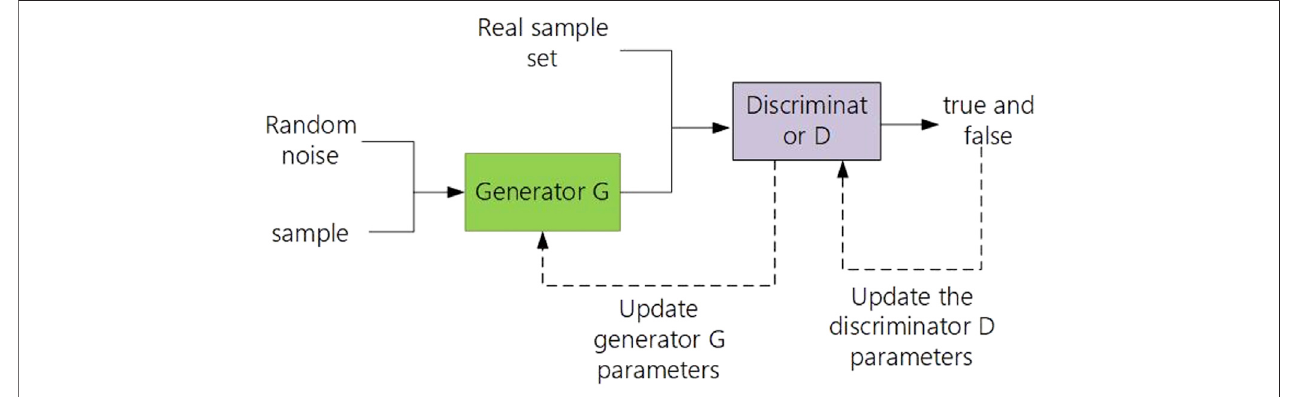
FIGURE 2 | Principle of the generative adversarial